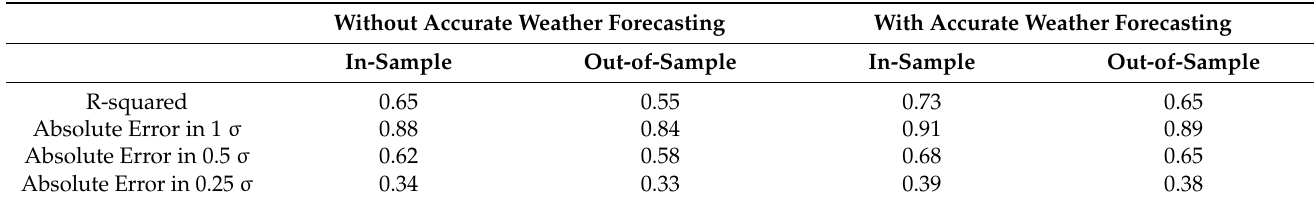
Table 11. R-squared and absolute errors in n σ of administrative district model with/without accurate weather forecasting (month: included, hidden layer layout: 12 × 12, threshold: 0.05).